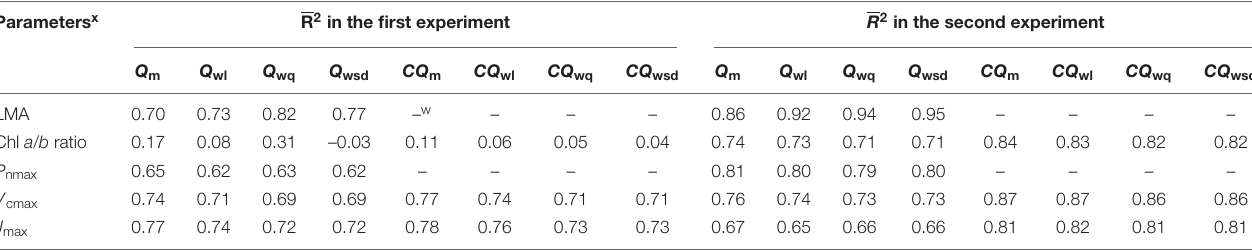
TABLE 1 | coefficient of determination ( R 2 ) from regression models of light acclimation parameters of cucumber leaves on the average of daily photosynthetic photon flux density (PPFD) ( Q m ), time-weighted averages of daily PPFD ( Q wz ), calibrated Q m ( CQ m y ), and calibrated Q w ( CQ w y ). Parameters x R 2 in the first experiment R 2 in the second experiment